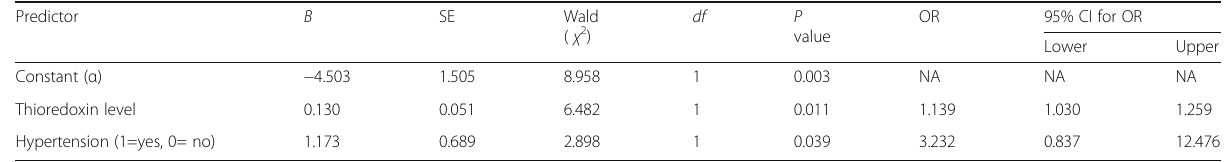
df P OR 95% CI for OR value ( χ 2 ) Lower Upper